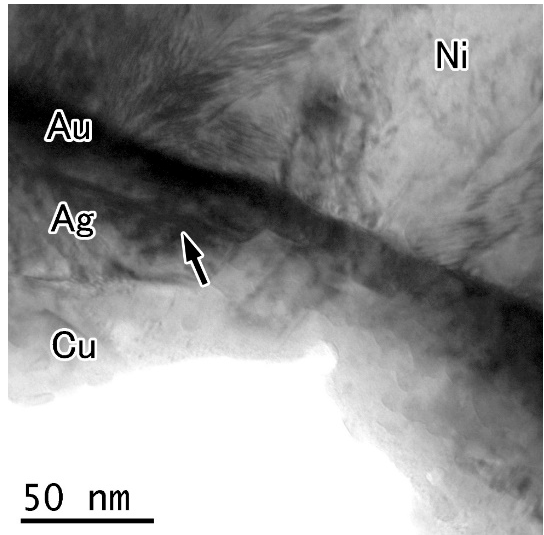
Figure 10. Bright field image of the interface. The arrow indicates a twin boundary.